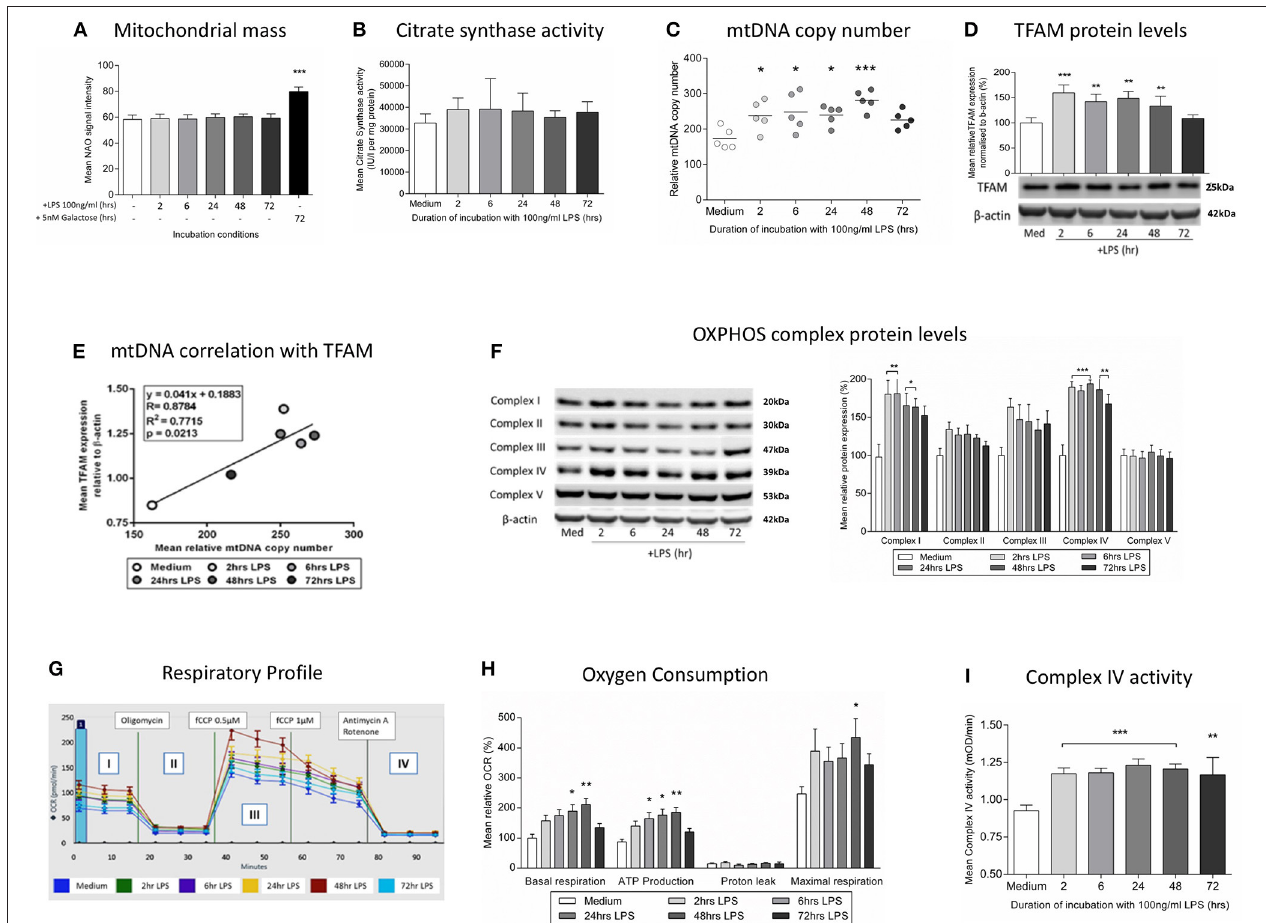
FIGURE 4 | Induction of mitochondrial biogenesis following exposure of THP-1 cells to LPS. THP-1 cells were incubated with LPS (100ng/ml) for 0–72h before assessing mitochondrial biogenesis and respiration. (A) Mitochondrial mass was assessed by measuring the uptake of NAO using flow cytometry, (positive control - glucose-free medium supplemented with 5mM galactose) ( n = 4). (B) A colorimetric assay was used to assess the activity of the mitochondrial matrix enzyme citrate synthase ( n = 3). (C) mtDNA copy number was determined by measuring MT-ND1 relative to B2M using qPCR ( n = 5). (D) The level of TFAM protein relative to β -actin was determined by Western blot ( n = 4). (E) Scatter plot, linear regression and Pearson’s correlation of the relationship between mtDNA copy number and TFAM protein levels. * p < 0.05, ** p < 0.01, *** p < 0.001. (F) Representative images of protein bands for subunits of the five mitochondrial OXPHOS complexes on PVDF membrane following Western blot and quantification of the subunits of the five mitochondrial OXPHOS complexes relative to β -actin ( n = 4). (G) Representative example of the respiratory profile and (H) oxygen consumption rate for different aspects of mitochondrial respiration following exposure to LPS (100ng/ml) for 0–72h as determined using the Seahorse XF96 e extracellular flux analyser ( n = 5). (I) A colorimetric assay was used to measure the activity of OXPHOS complex IV( n = 3). The data are represented as (A) individual values with a line indicating the mean or (B,C,F,H,I) mean ± standard deviation relative to the mean in the medium control; * p < 0.05, ** p < 0.01, *** p <